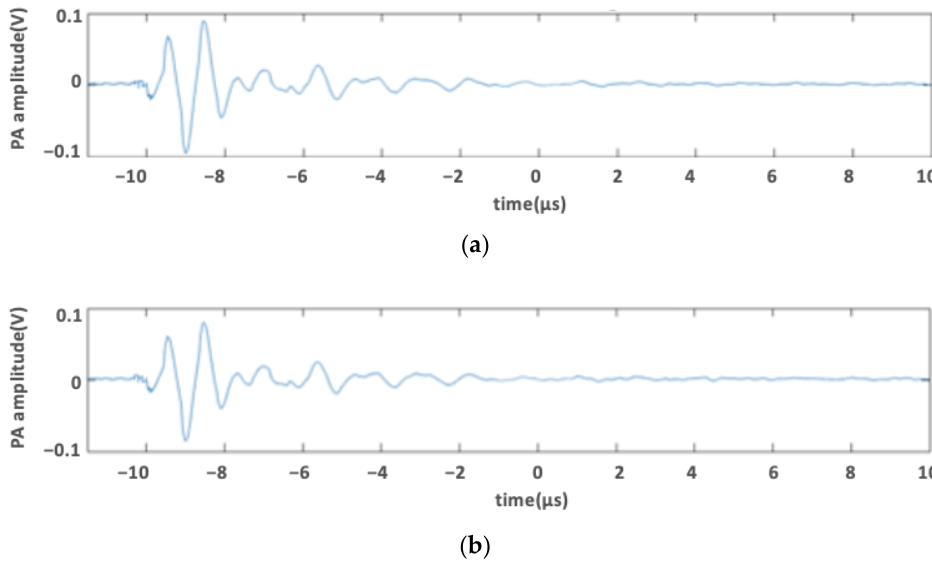
Figure 2. Photoacoustic signal of ( a ) blood and ( b ) 25% ( v / v ) phenol red in medium acquired for laser fluence of 0.77 mJ/cm 2 at 532 nm laser wavelength.